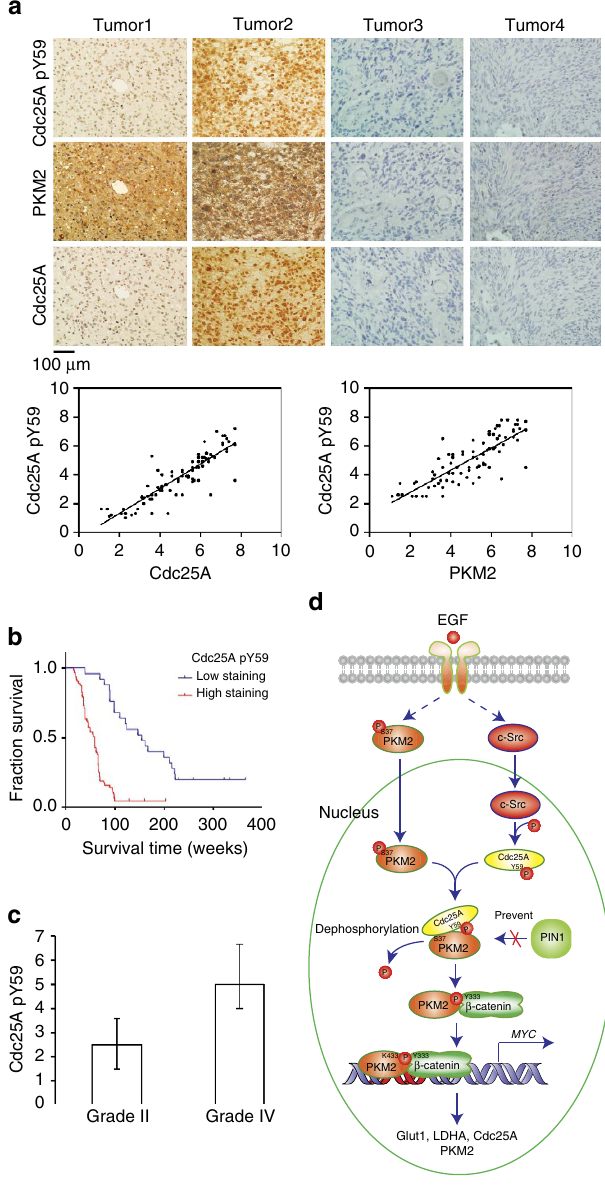
and Cdc25A, the Warburg effect and